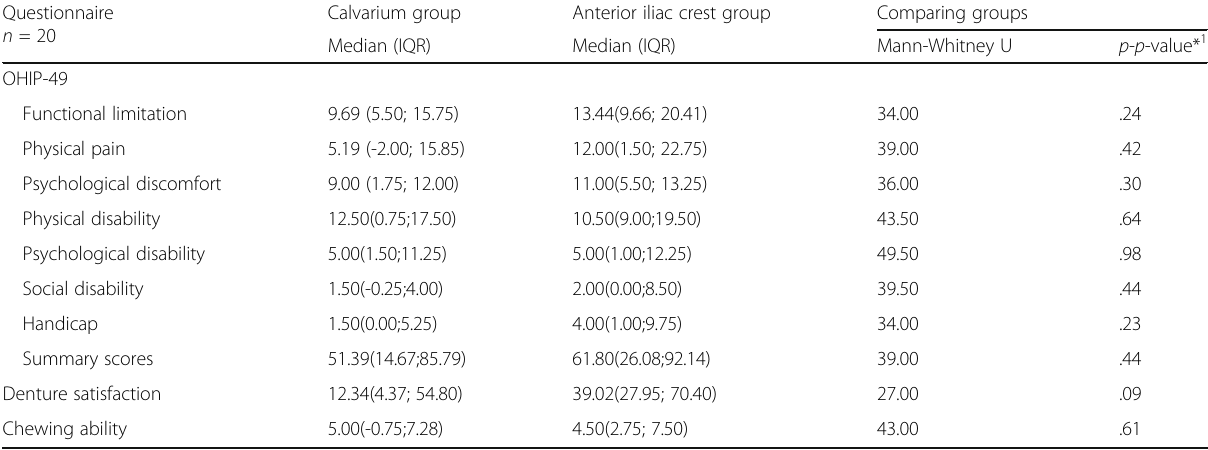
Table 3 OHIP-49 scores, denture satisfaction and chewing ability: group score changes following treatment Questionnaire n = 20